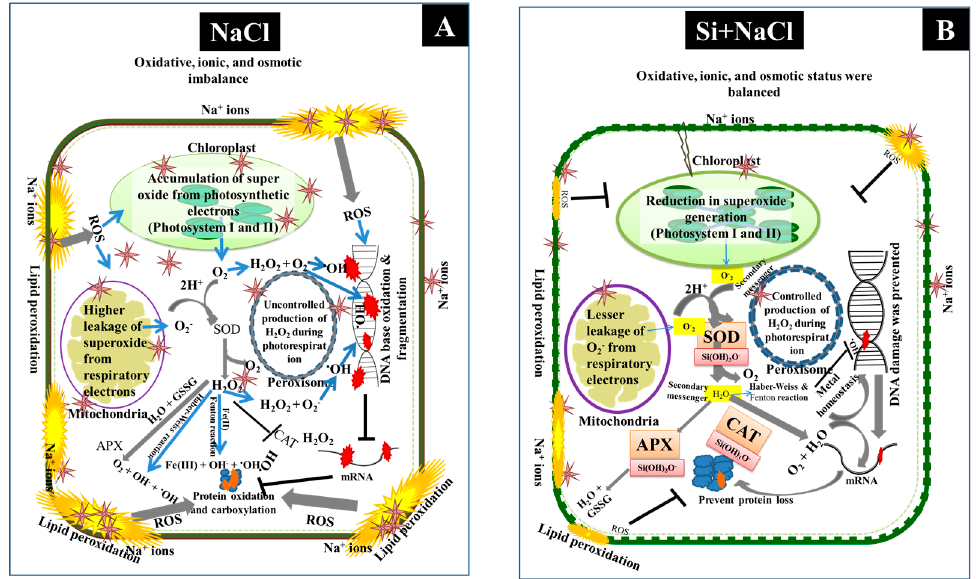
Figure 10. A possible simple and heuristic representation of oxidative damages occurred under salt stress conditions ( A ) and the amelioration of stress under Si supplementation by the induction of antioxidant enzymes and the prevention of nucleic acid and protein damages ( B ). The following are key for the symbolic representations provided in the figure: brown star, Na + ions; red sparks, oxidation and fragmentation of DNA due to ·OH bound to DNA base; orange sparks, oxidation and carbonylation of proteins; grey arrow, normal or enhanced metabolism; black line with bar, reduction or inhibition; blue arrows, diffusion of ROS; green lines, cell wall layers including lipid bilayer; and small green squares on the membrane, polymerization of Si in cell wall.